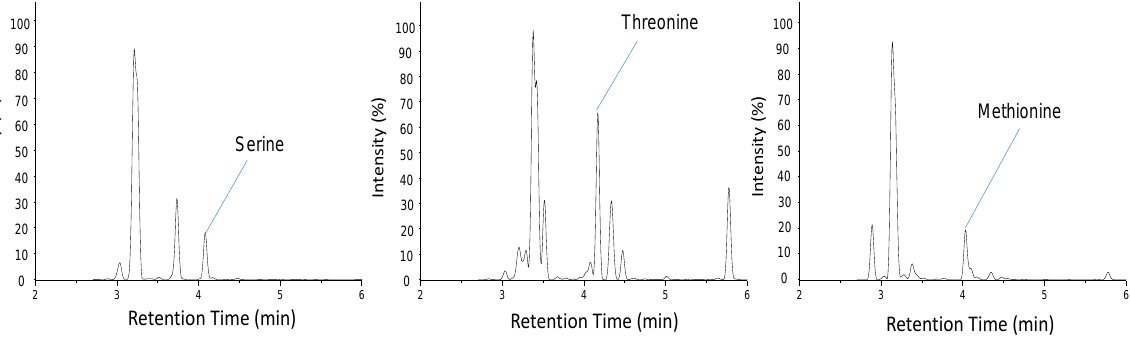
Figure 6. Mass spectra of coeluting derivatized alanine and glycine.